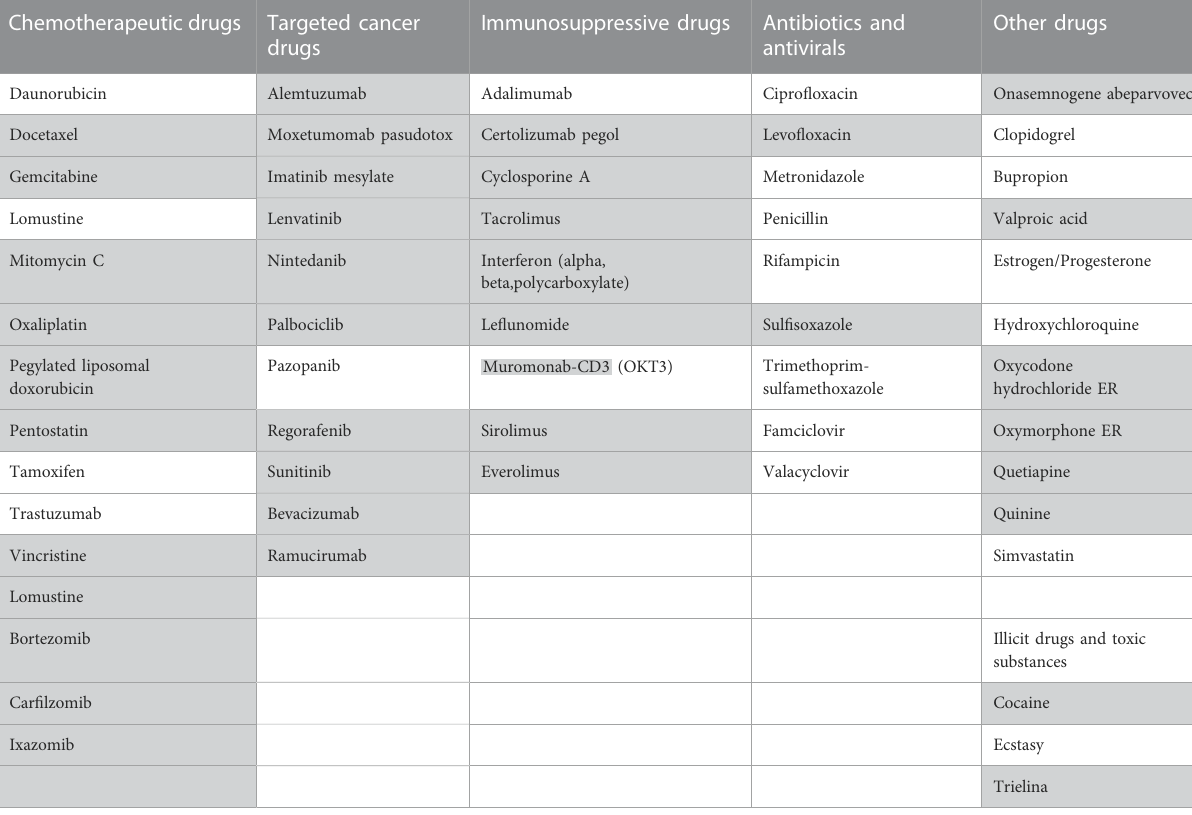
TABLE 1 Drugs reported to have a probable or de fi nite association with